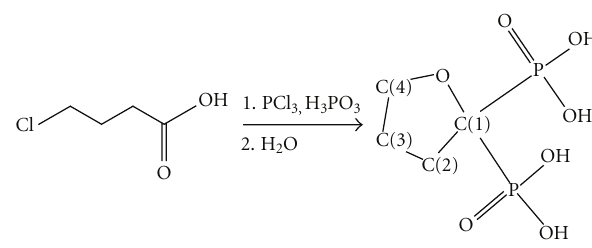
Scheme 1: Synthetic methodology for synthesis of Na 2 H 2 L along with the numbering scheme of C-atoms for NMR peak assignments.